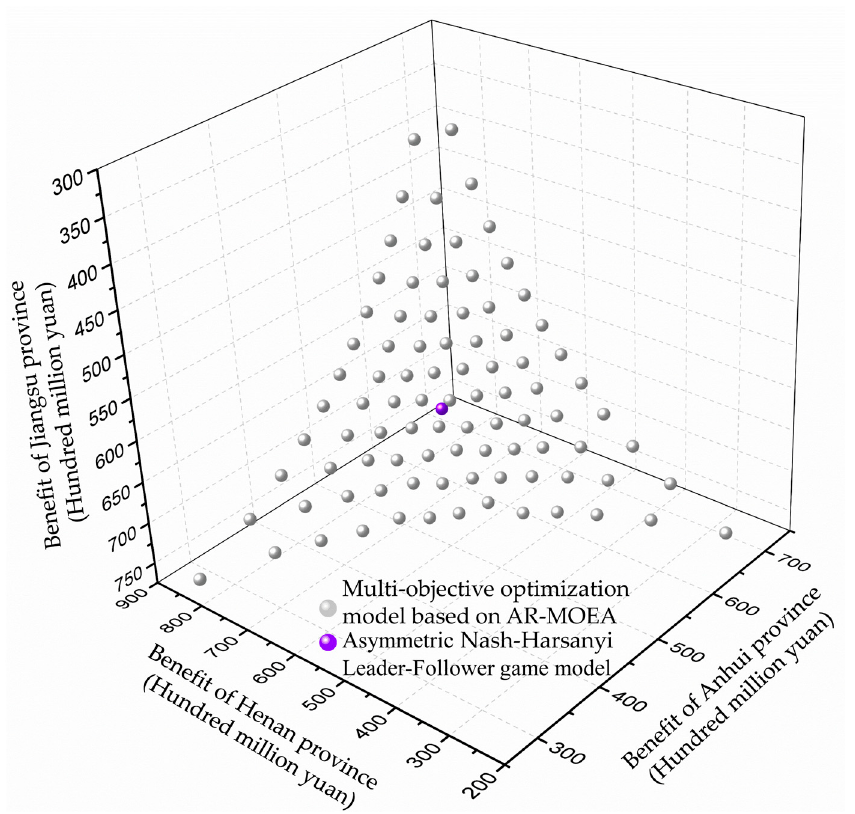
Figure 6. The benefits of three provinces of the Huaihe River obtained by the two models.